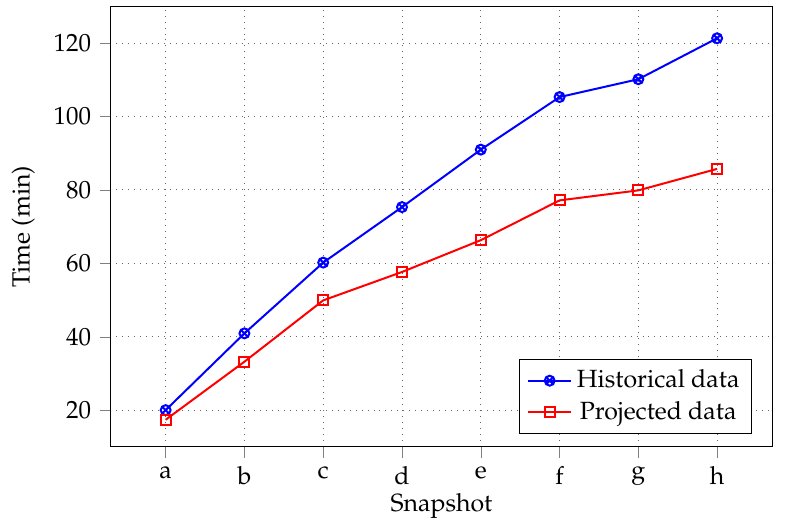
Figure 12. Simulation times for the eight snapshots shown in Figure 11. The blue (circle) line represents the flooding time obtained by simulating the flow rate in an intense rainfall event using historical data (20-year return values), and the red (square) line represents these values intensified by 12% due to potential effects of CC.